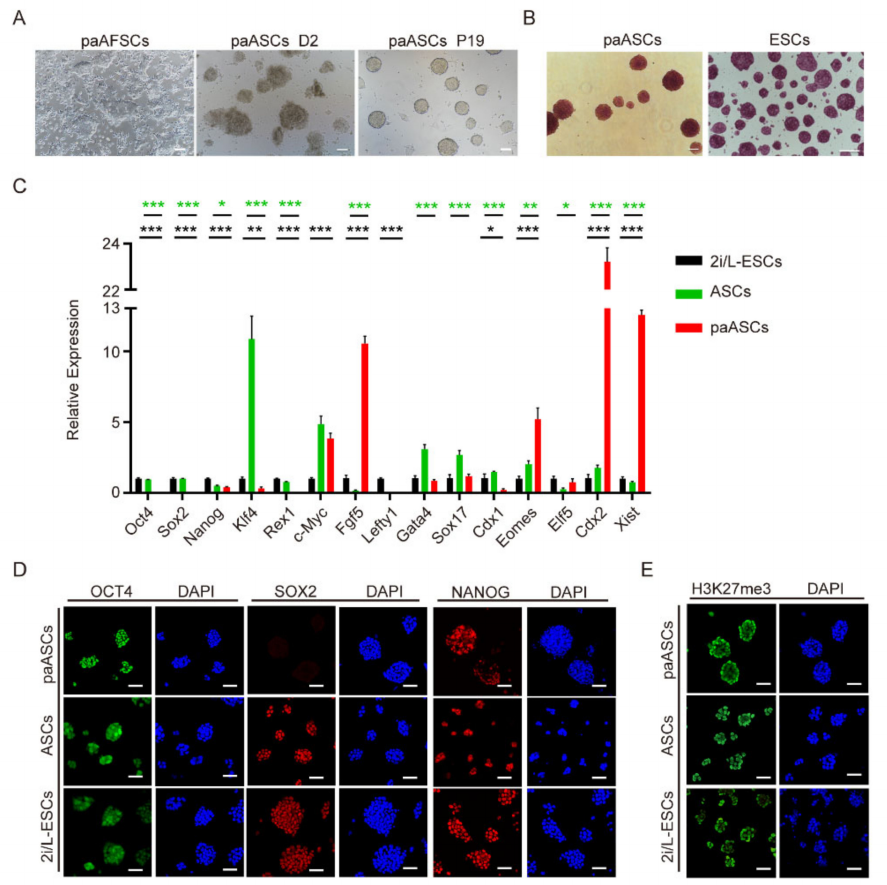
Figure 3. Conversion and characteristics of paASCs. ( A ) The morphological change during the conversion from paAFSCs to paASCs; D2: culture in ABCL medium for 2 days; P19: passage 19; scale bars: 100 µ m. ( B ) PaASCs exhibited similar AP staining results to those of ESCs; scale bars: 100 µ m. ( C ) RT-qPCR of key pluripotent genes, germ-layer-related genes, and X-chromosome- inactivation-related genes in 2i/L-ESCs, ASCs and paASCs. Error bars indicate three independent biological replicates (mean ± SD). * p < 0.05, ** p < 0.001, *** p < 0.0001. ( D ) Immunostaining for pluripotent markers OCT4, SOX2 and NANOG in 2i/L-ESCs, ASCs, and paASCs; scale bars: 50 µ m. ( E ) Immunostaining for H3K27me3 in 2i/L-ESCs, ASCs, and paASCs. Scale bars: 50 µ